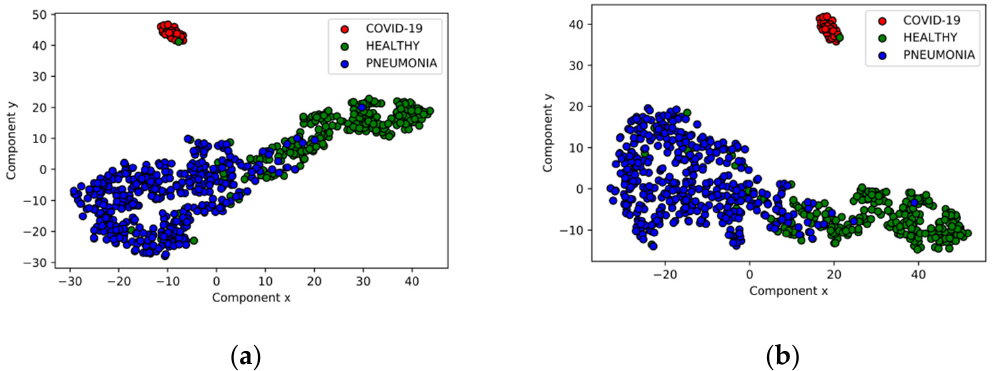
Figure 11. t-SNE of predicted outputs for test set: ( a ) shows the instances using random initialization; ( b ) shows the instances using principal component analysis (PCA) for initialization.